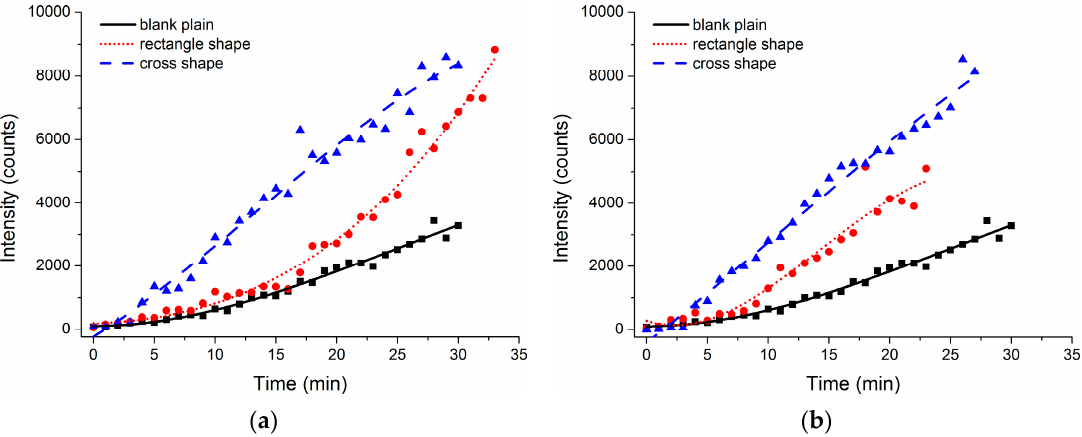
Figure 7. The laser-induced fluorescence intensity of the concentrated Rh6g solvent after an extraction time of half an hour. ( a ) The velocity of the aqueous and organic phases was set at 3 and 18 mL·h − 1 respectively; ( b ) the velocity of the aqueous and organic phases was set at 4 and 24 mL·h − 1 ,